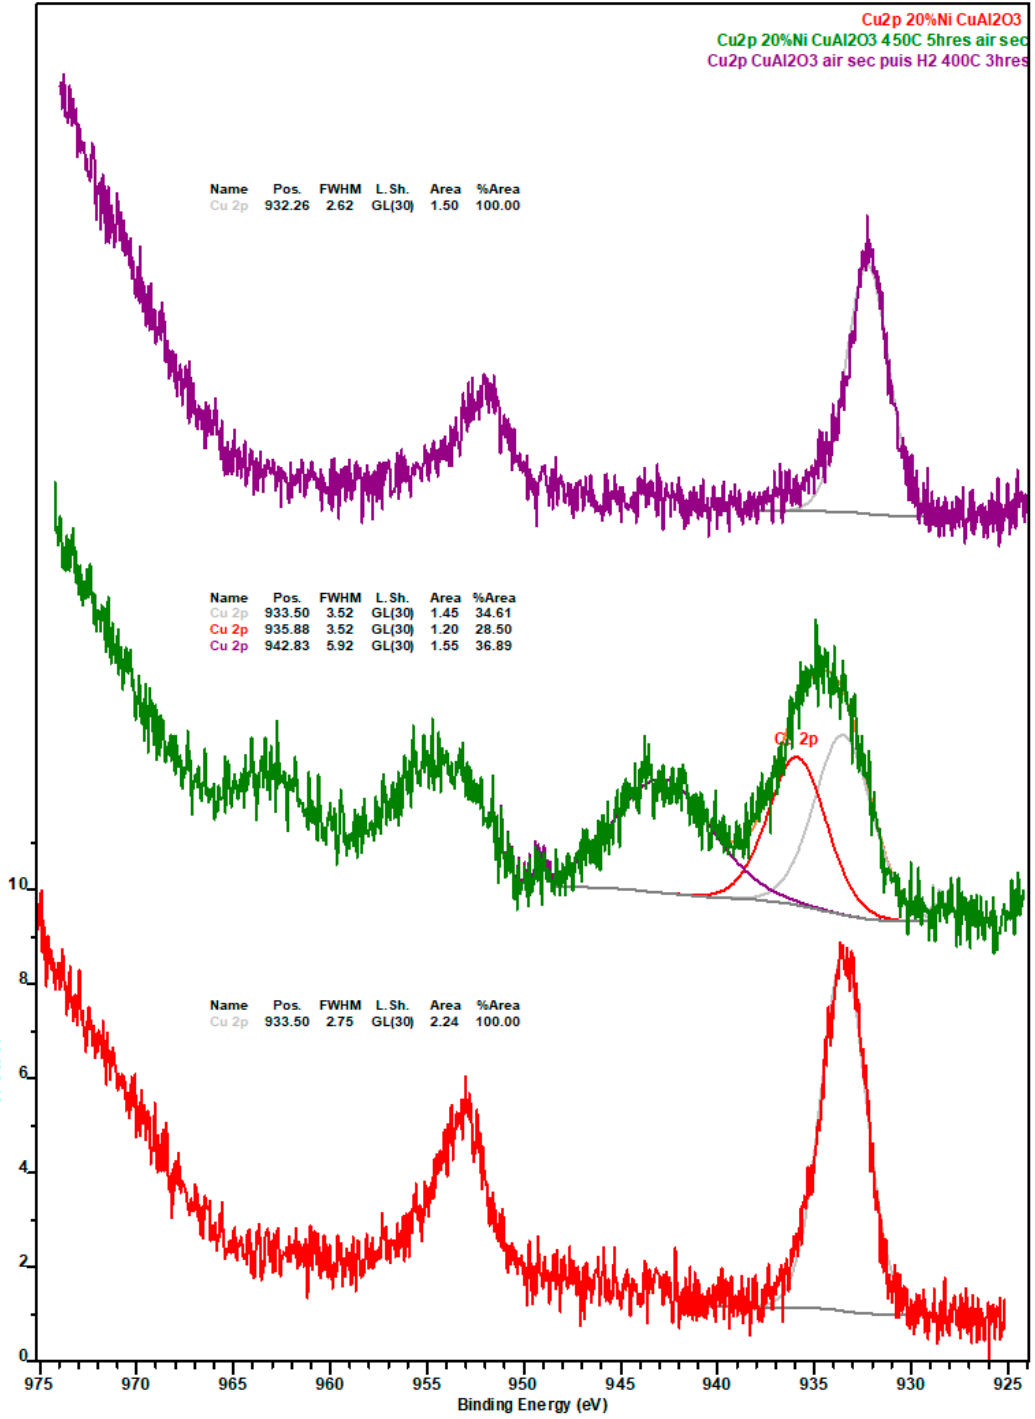
Figure A7. Copper 2p X-ray photoelectron spectra of the spent Ni-Cu catalyst after the deoxygenation experiment (red spectrum), after calcination in air at 450 °C for 5 h (green spectrum), and reduction under H 2 at 400 °C for 3 h (purple spectrum).